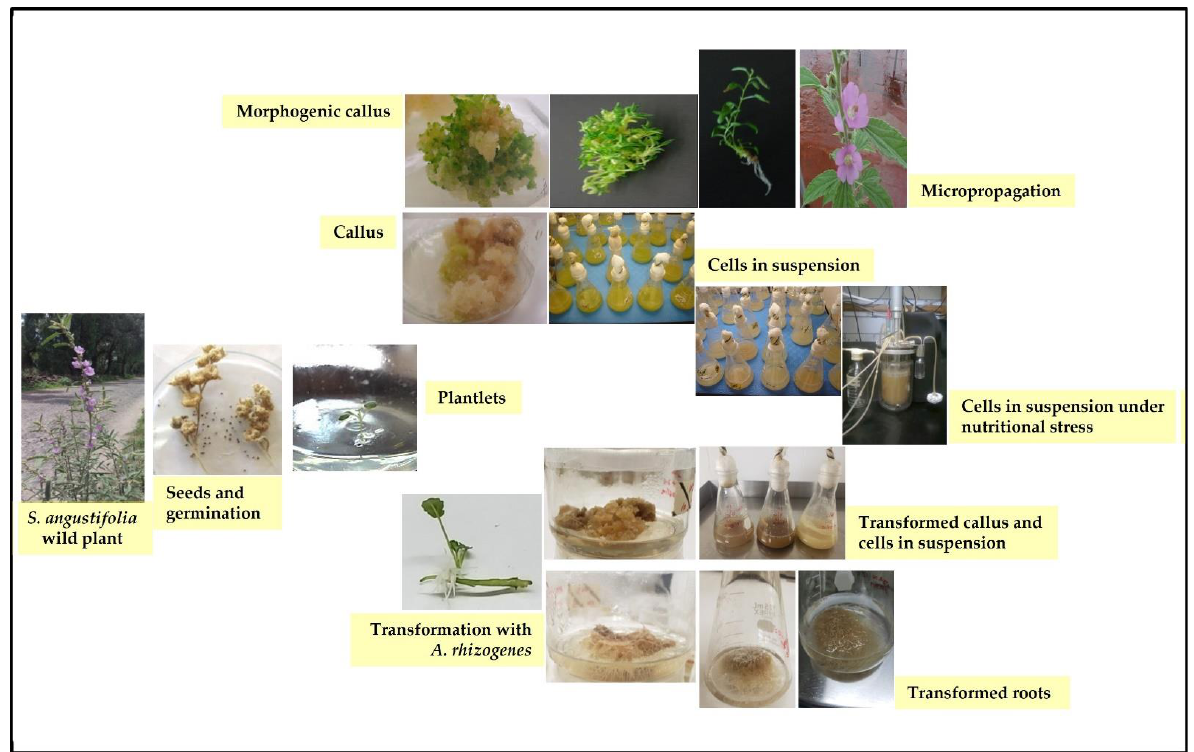
Figure 3. In vitro cultures established Sphaeralcea angustifolia as producers of active